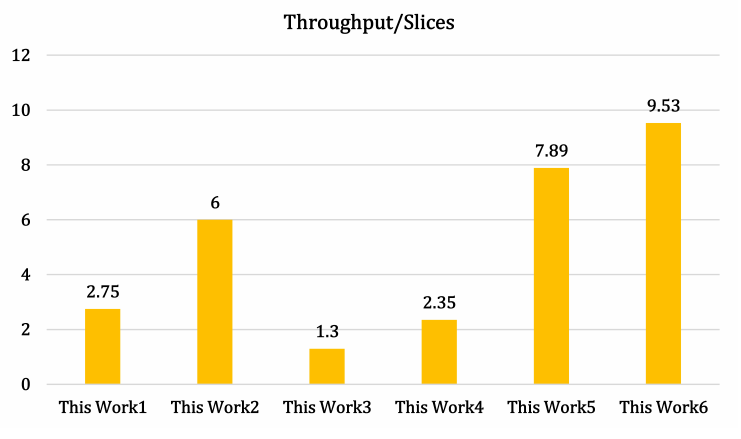
Figure 3. Design metric ( throughput